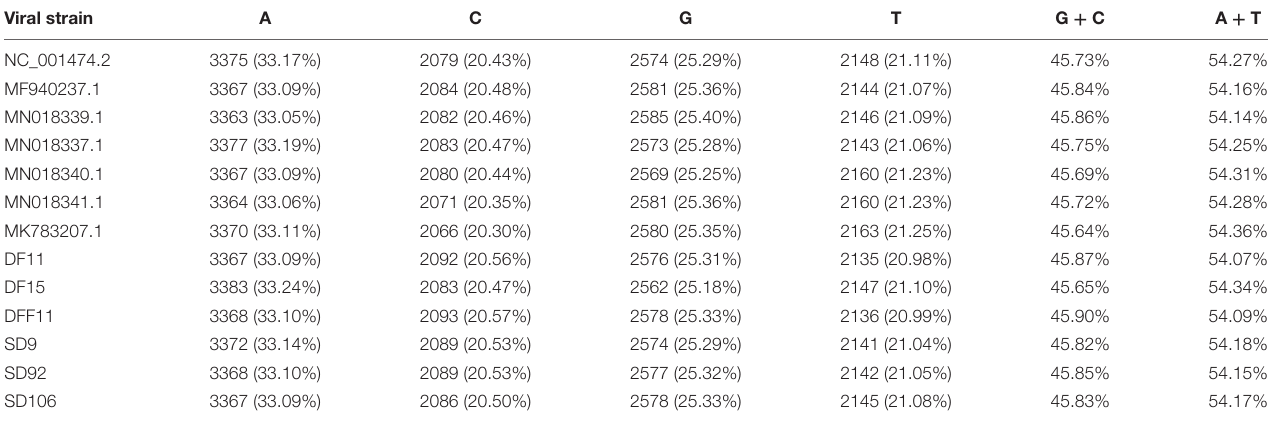
TABLE 5 | Basic information on the DENV-2 sequences was analyzed by